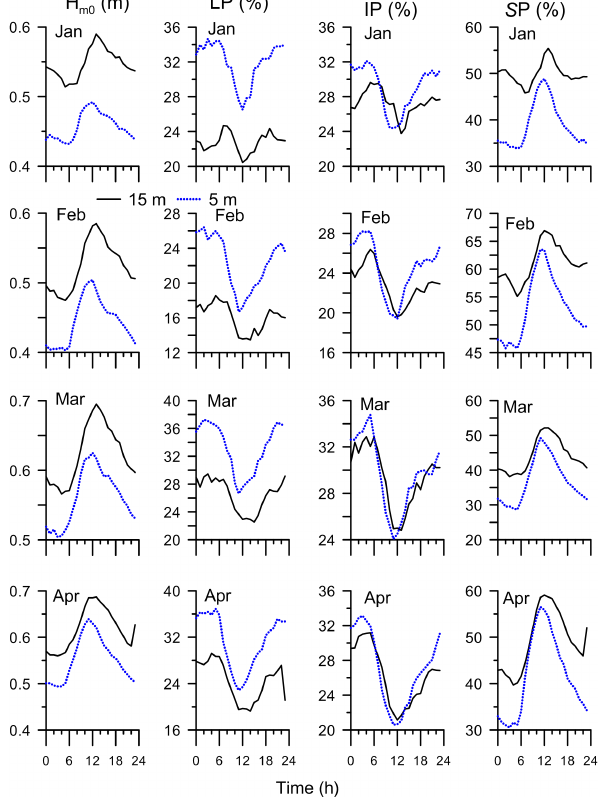
Figure 6. Variation in 1 / 2 hourly averaged wave parameters; (a) significant wave height ( H m0 ) , (b) percentage of long-period (LP) waves, (c) percentage of intermediate period (IP) waves and (d) percentage of short-period (SP) waves.